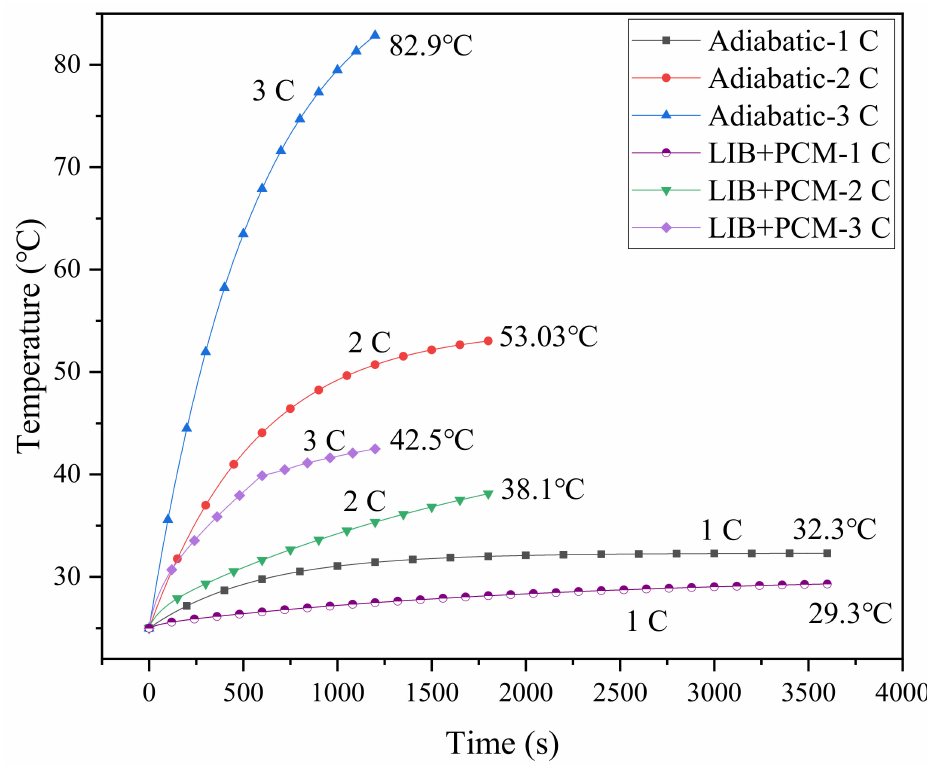
Figure 4. Battery temperature in the case of adiabatic conditions and cooling with